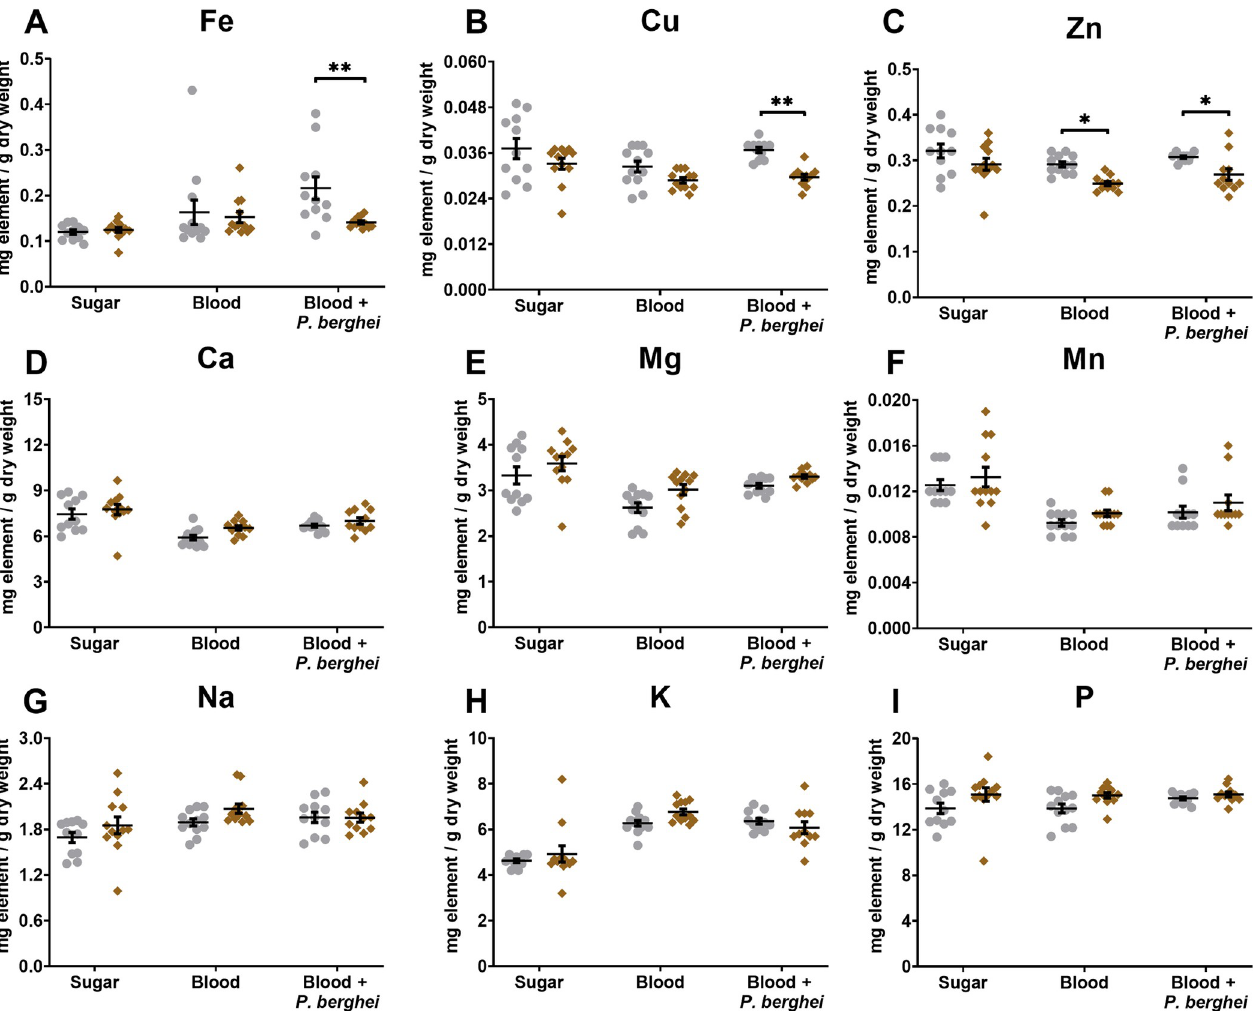
Fig 3. Metallomics following P . berghei infection of An . albimanus ws and bs phenotypes. Elemental concentrations of A) iron, B) copper, C) zinc, D) calcium, E) magnesium, F) manganese, G) sodium, H) potassium, and I) phosphorus, were determined in ws (grey circles) and bs (brown diamonds) phenotypes from An . albimanus seven days post P . berghei infection (Blood + P . berghei ), post feeding with uninfected blood (Blood) or continued feeding with sugar only (Sugar). The data are expressed in mg element per g dry weight, showing the mean ± SE from independent measurements taken in three experimental repeats. Numerical values can be found in S3 Table. Two-way ANOVA followed by Bonferroni’s multiple comparisons test was used to determine differences between phenotypes in each treatment; indicated with two asterisks. Specifically, �� for Fe p = 0.006, �� for Cu p = 0.003, � for Zn (Blood) p = 0.01, � for Zn (Blood + P . berghei ) p =